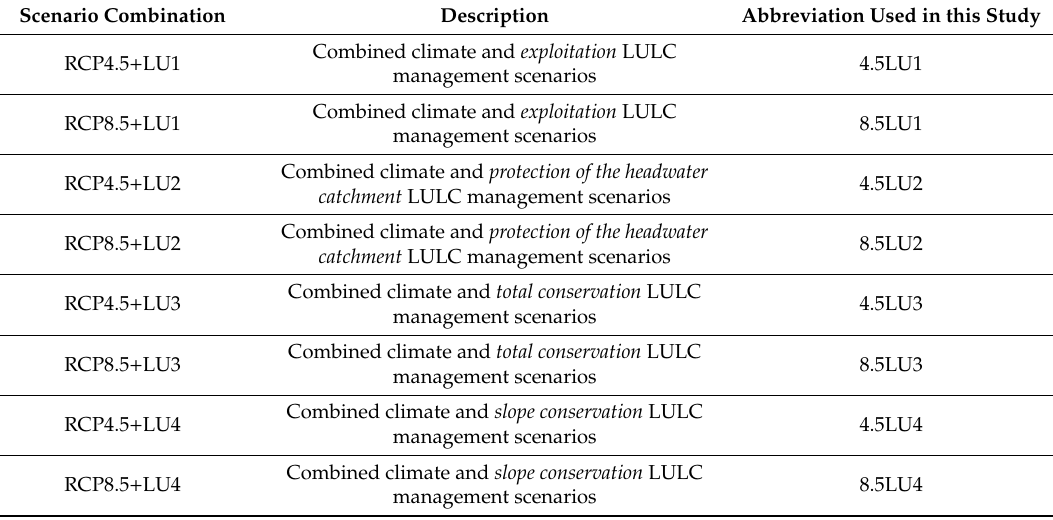
Table 2. Scenario combinations of climate change and di ff erent land use / land cover (LULC) management scenarios. LU1, exploitation ; LU2, protection of headwater catchment ; LU3, total conservation approach ; and LU4, slope conservation LULC